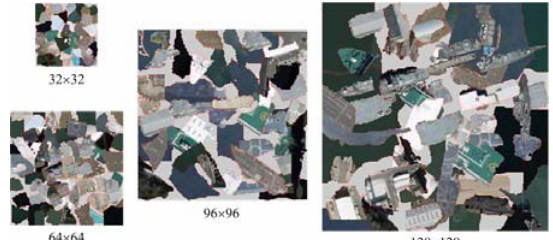
Figure 8. Hierarchical semantic graph for ship category